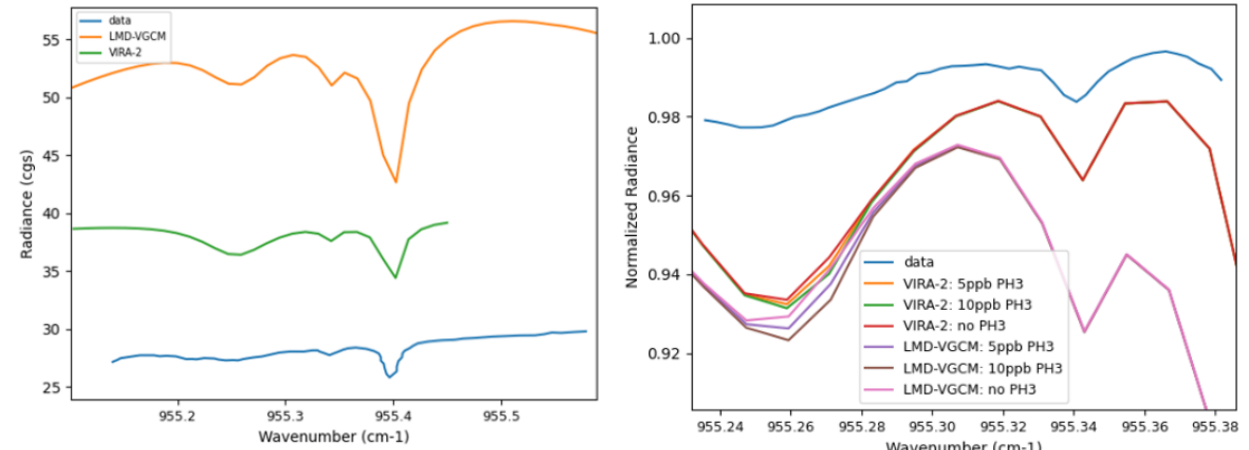
Figure 11. ( Left panel ) Comparison between the simulation and observations (blue) by Encrenaz et al. [22], using the VIRA-2 model (green) ([60]) and the LMD-VGCM model (orange) [58,59] as inputs for PSG. The LMD-VGCM model presents the higher values of radiance. Moreover, it has deeper and broader CO 2 lines than the VIRA-2 model and data. Both simulations have broader and deeper CO 2 lines than the data, as well as stronger water absorption at approximately 955.2–955.3 cm − 1 . cgs units = erg s − 1 cm − 2 sr − 1 ( cm − 1 ) − 1 ; ( Right panel ) Zoom of the left plot at approximately 955.24–955.38 cm − 1 in normalized radiance units. The effect of different abundances of phosphine, 5 ppb and 10 ppb, in the simulations, are shown. The normalized radiance of our simulation, at approximately 955.25 cm − 1 , is approximately 4% and 5% deeper than the normalized radiance of the data for, respectively, the VIRA-2 model and the LMD-VGCM model, when considering the simulations with 5 ppb of PH 3 . The uncertainty of the datapoints of the observations is approximately 5%. The error of the simulations is approximately